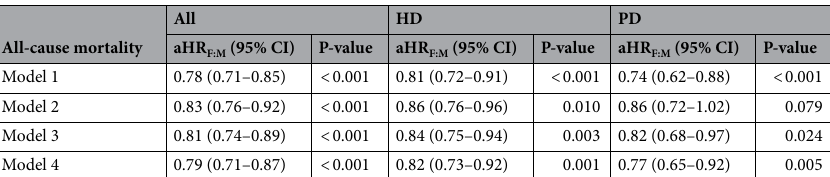
All-cause mortality